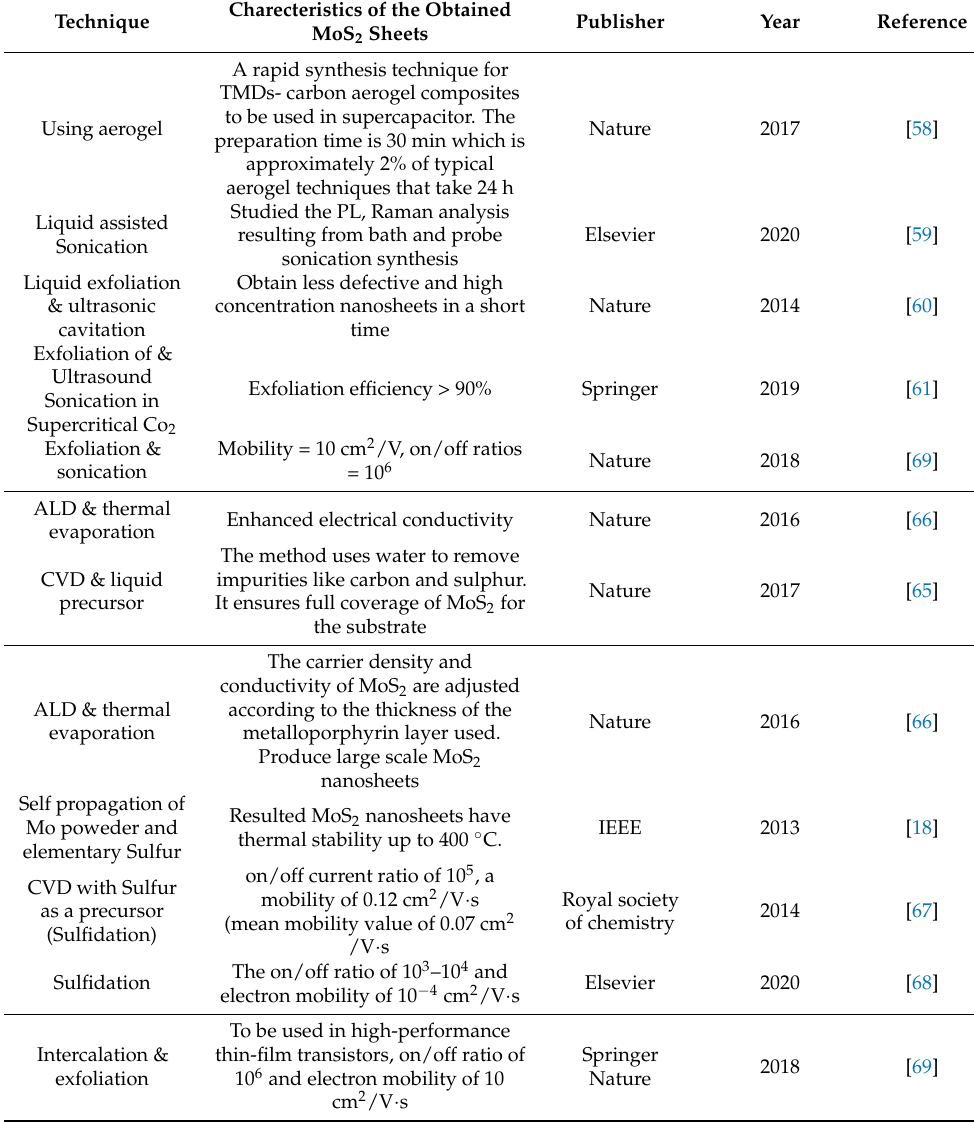
Table 3. Summary of synthesis